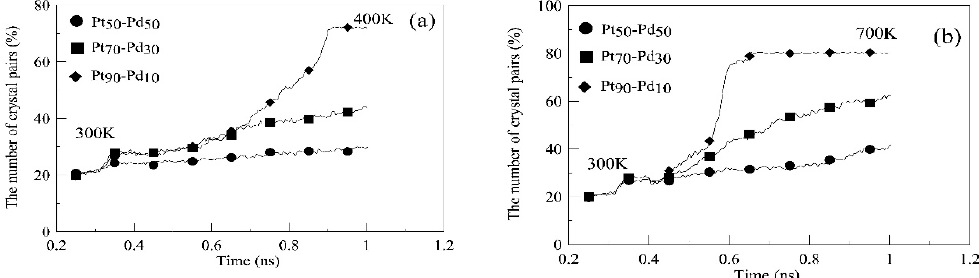
Figure 2. The variation of the number of crystal bonded pairs with time for different Pt concentration rates in Pt-Pd alloy during annealing; ( a ) 400 K annealing temperature, ( b ) 700 K annealing temperature.